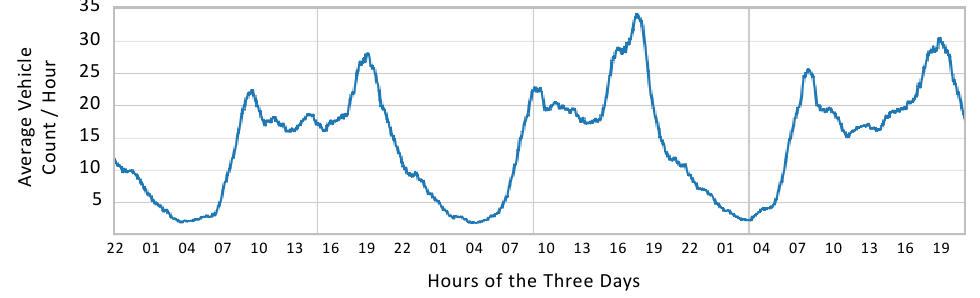
Figure 12. Average traffic volume (number of vehicles per hour) data as provided by the system over a period of three